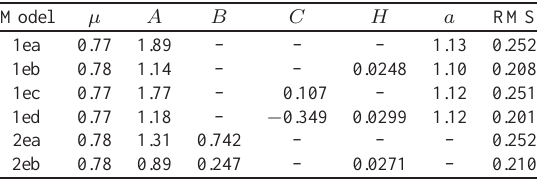
Table 4 Least squares fit results for peak overpressure data (energy